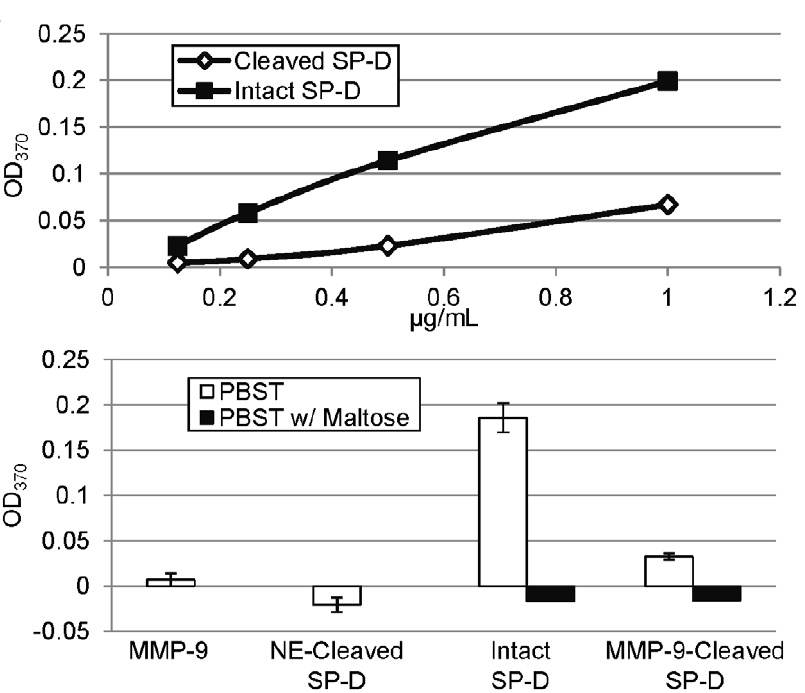
Figure 4. Cleaved SP-D Retains its Ability to Bind E.coli LPS. Examination of the ability of SP-D to bind to LPS-coated plates. In (A), the ELISA was performed using 2-fold serially diluted SP-D samples. In (B), 1 m g/mL intact or cleaved SP-D was analyzed in triplicate with MMP-9 as a control and NE-cleaved SP-D as a negative control. The average of PBST alone ran in triplicate was subtracted from all values. While intact and MMP-9-cleaved SP-D in PBST are significantly different from PBST alone (p # 0.001 and p , 0.05, respectively) and NE-cleaved SP-D (p # 0.001 and p , 0.05, respectively), MMP-9 along with intact and cleaved SP-D in PBST with maltose were not significantly different from PBST or PBST with maltose. For (B), error bars represent standard deviation.